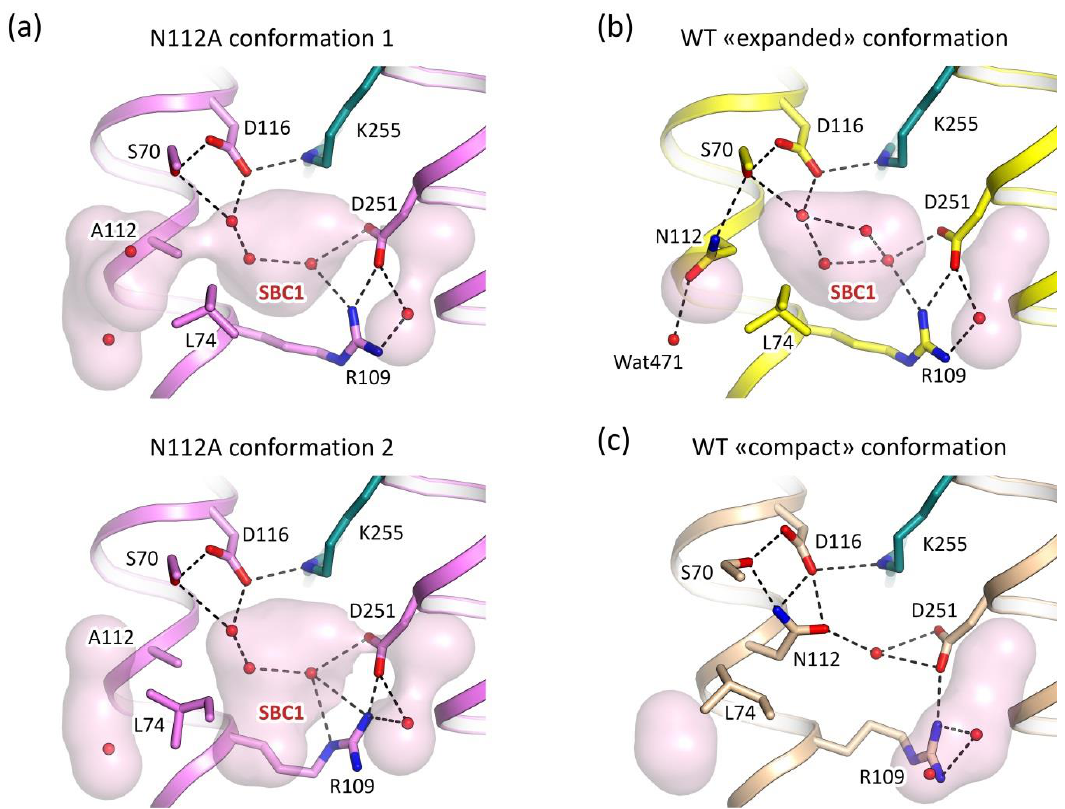
Figure 3. Schiff base region of the N112A mutant. ( a ) Two conformations of the RSB region of the N112A mutant of KR2 (PDB ID: 6YT4, present work). The flip of the L74 side chain leads to the enlargement of the Schiff base cavity 1 (marked SBC1 in the Figure) in the conformation 2. ( b ) The “expanded” conformation of the WT KR2 (PDB ID: 6YC3 [41]). ( c ) The “compact” conformation of the WT KR2 (PDB ID: 4XTN, chain I [2]). Water molecules are shown with red spheres. Cavities were calculated using HOLLOW [57] and are shown with a pink surface. Hydrogen bonds are shown with black dashed lines. The side chain of the K255 residue and covalently bound retinal cofactor are colored teal.